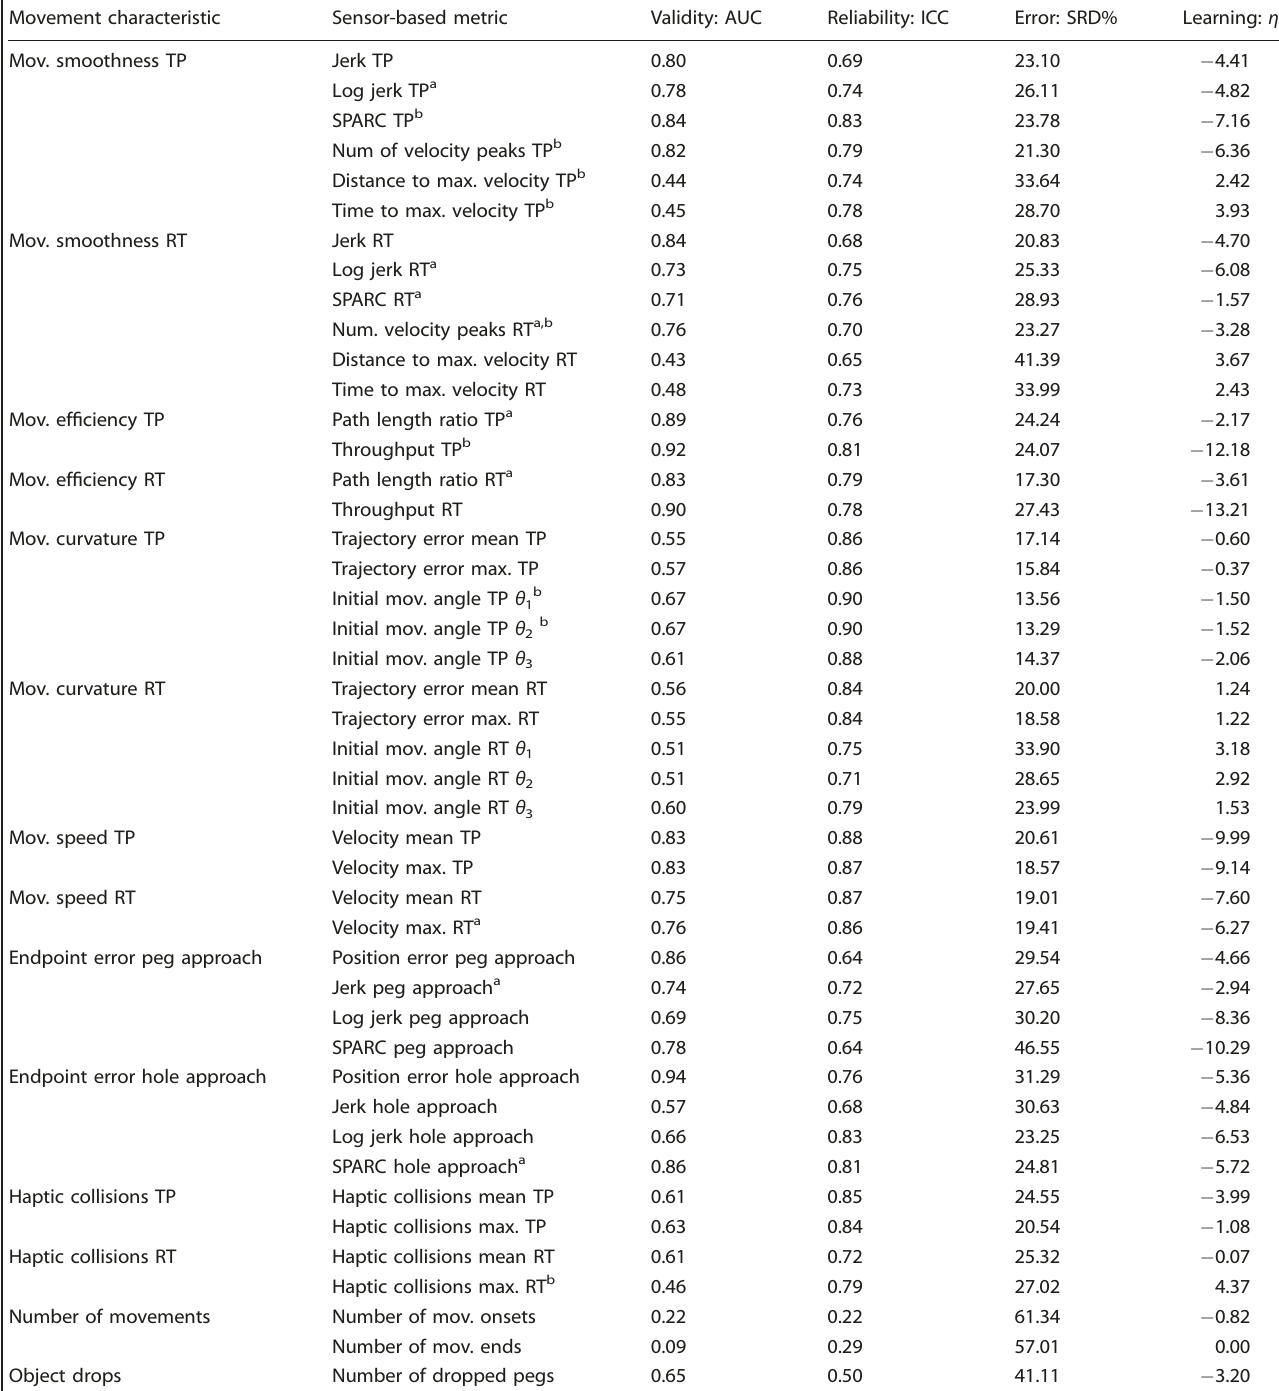
Table 2. Results for the data-driven selection of kinematic metrics. Movement